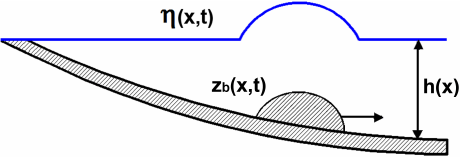
Fig. 2. The geometry of the problem: the water displacement η(x,t) is generated by the landslide with the shape z b (x,t) above the variable bottom profile h(x)